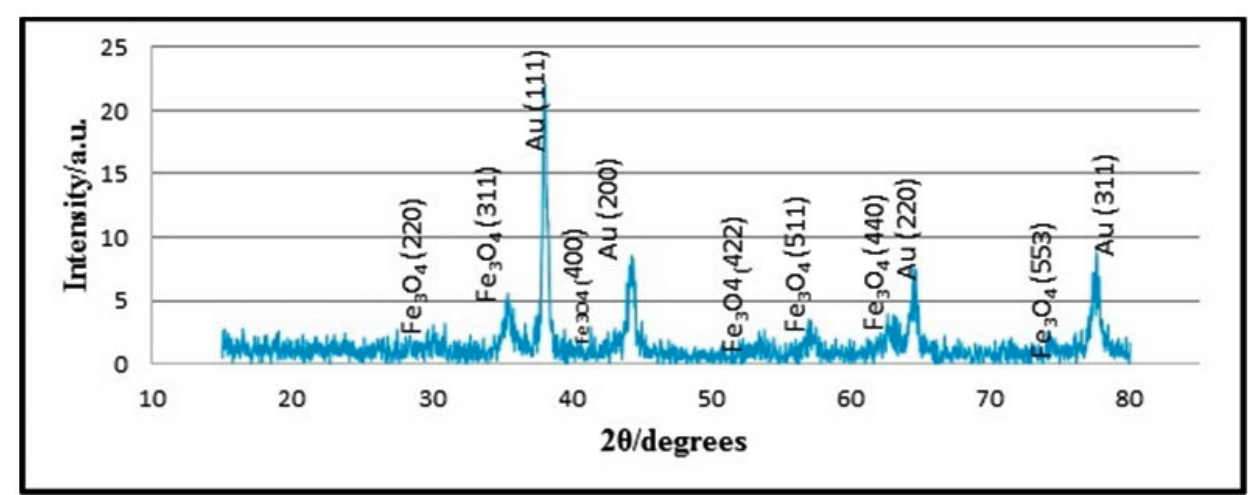
O nanoparticles the main characteristic 3 4